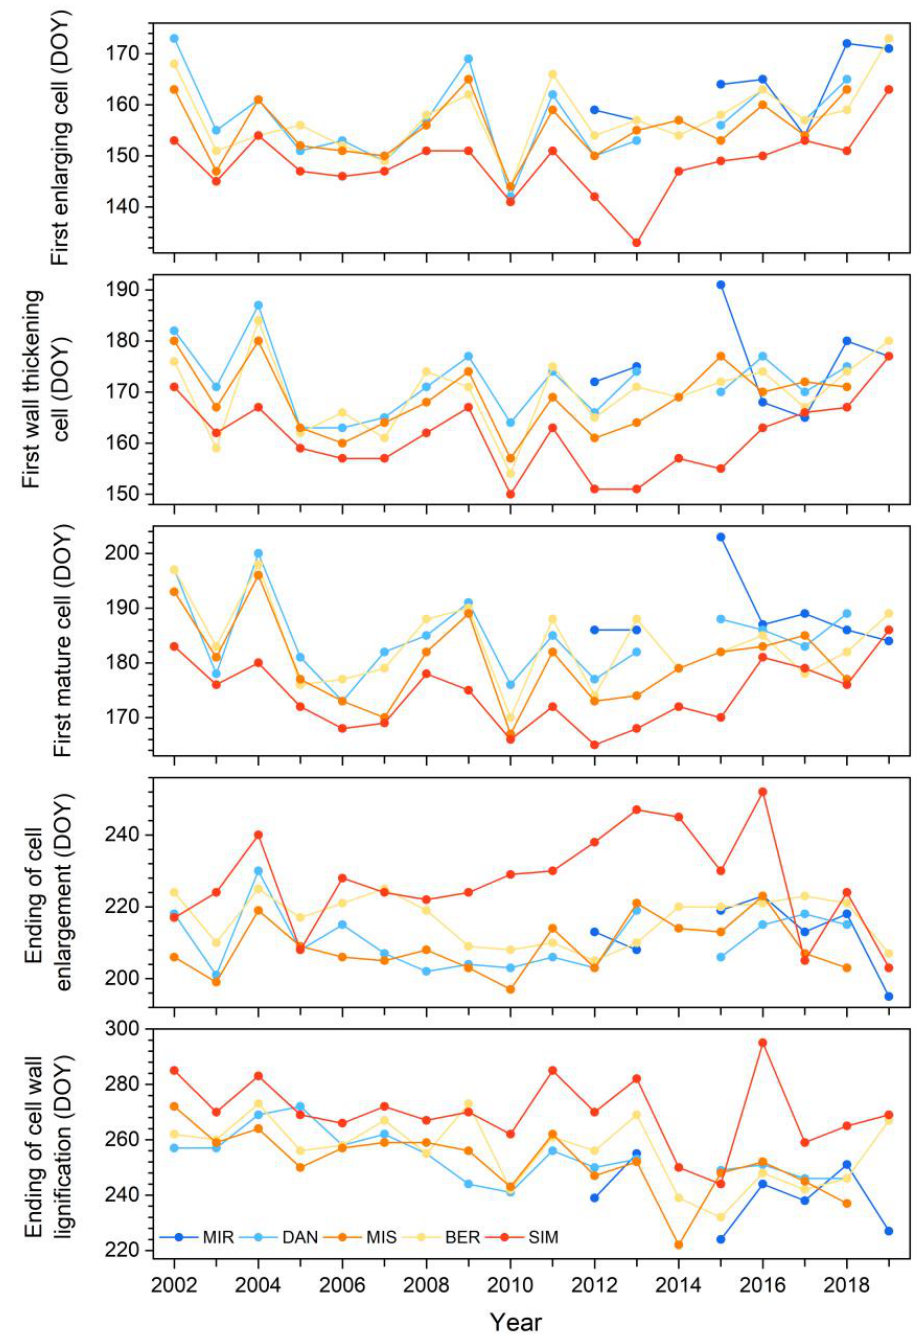
Figure 4. Timings of xylem phenology of black spruce recorded at the five permanent sites of the boreal forest of Quebec, Canada.